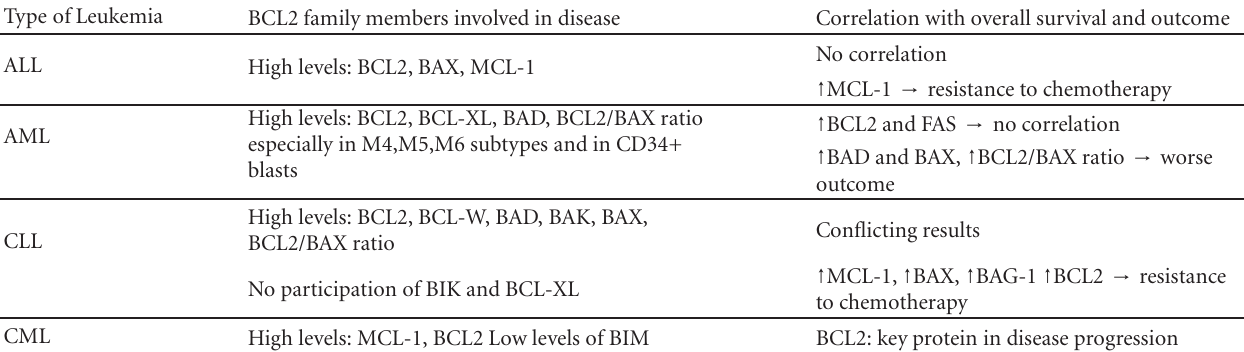
Table 1: This table summarizes the general findings regarding BCL2 family members in each type of leukemia. Type of Leukemia